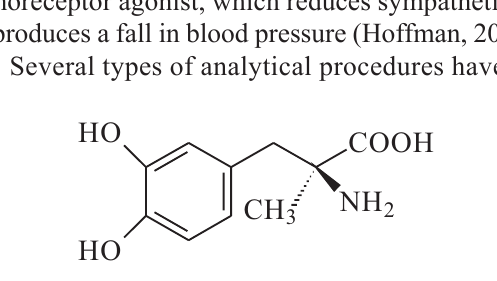
FIGURE 1 - Chemical structure of